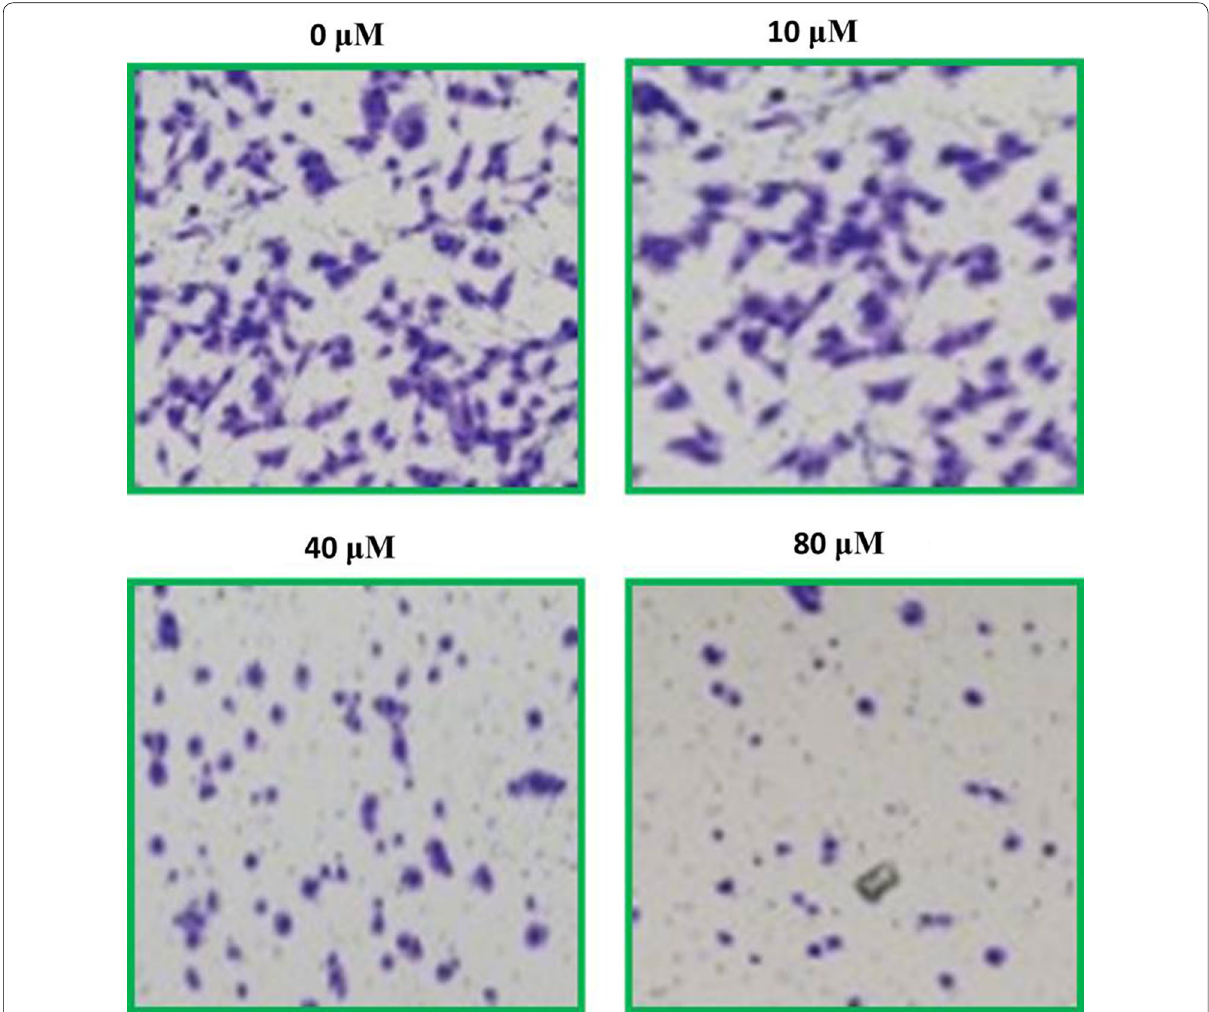
Fig. 8 Images presenting the cellular migration of SHSY-5Y cells after being exposed to maslinic acid at indicated doses. For maximum precision three individual experiments were